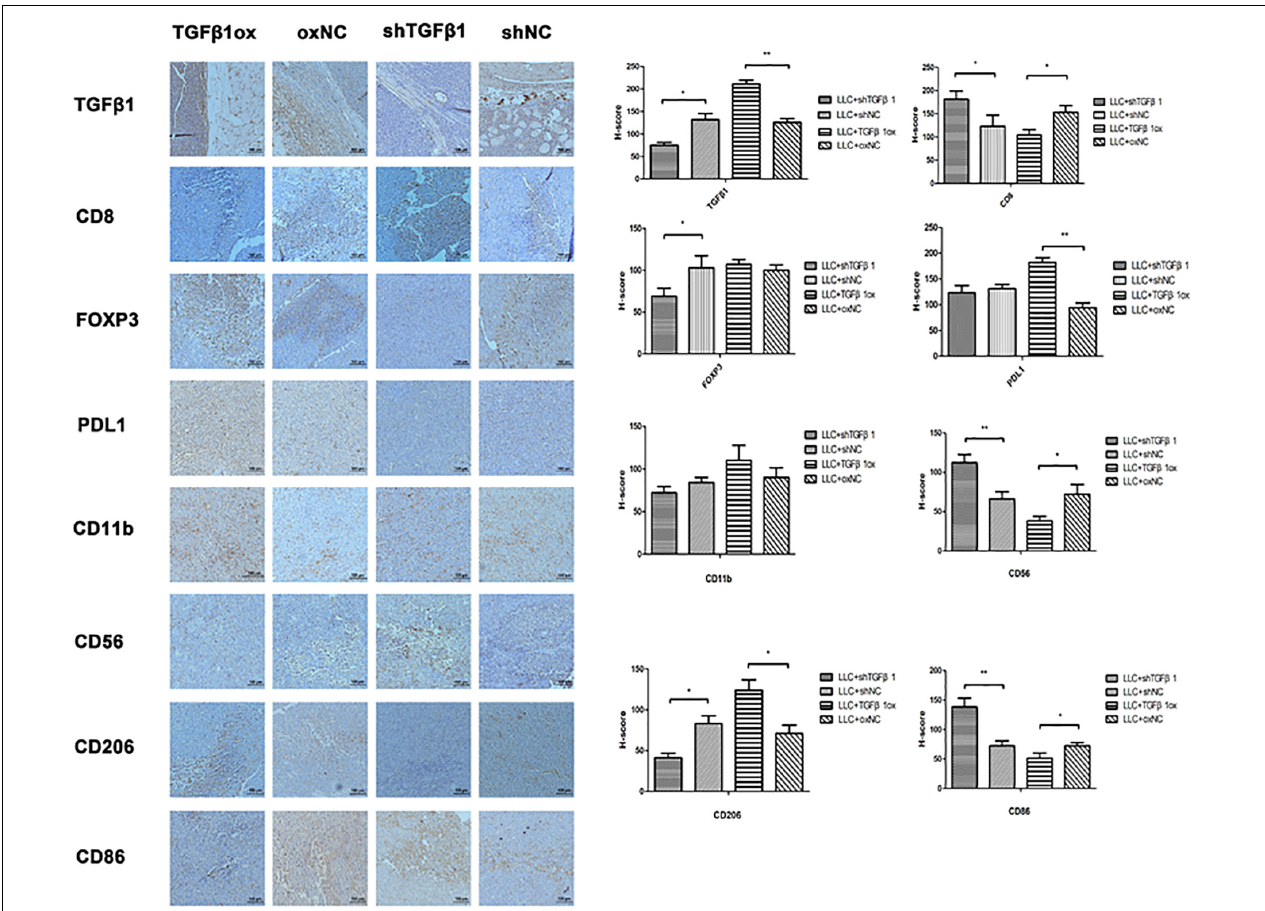
FIGURE 6 | The impact of different TGF β 1 level in CAFs on tumor immunology. Immumohistochemical staining of lung cancer tissues in mice for TGF β 1, CD8, FOXP3, PDL1, CD56, CD11b, CD86, and CD206. TGF β 1 overexpression in CAFs inhibited the antitumor immunity of lung cancer xenograft. Statistical significance is shown ( ∗ p < 0.05; ∗∗ p < 0.01). shNC and oxNC, control groups corresponding to knockdown and overexpression of TGF β 1 recombinant lentiviral infection; shTGF β 1 and TGF β 1ox, knockdown and overexpression of TGF β 1 recombinant lentiviral